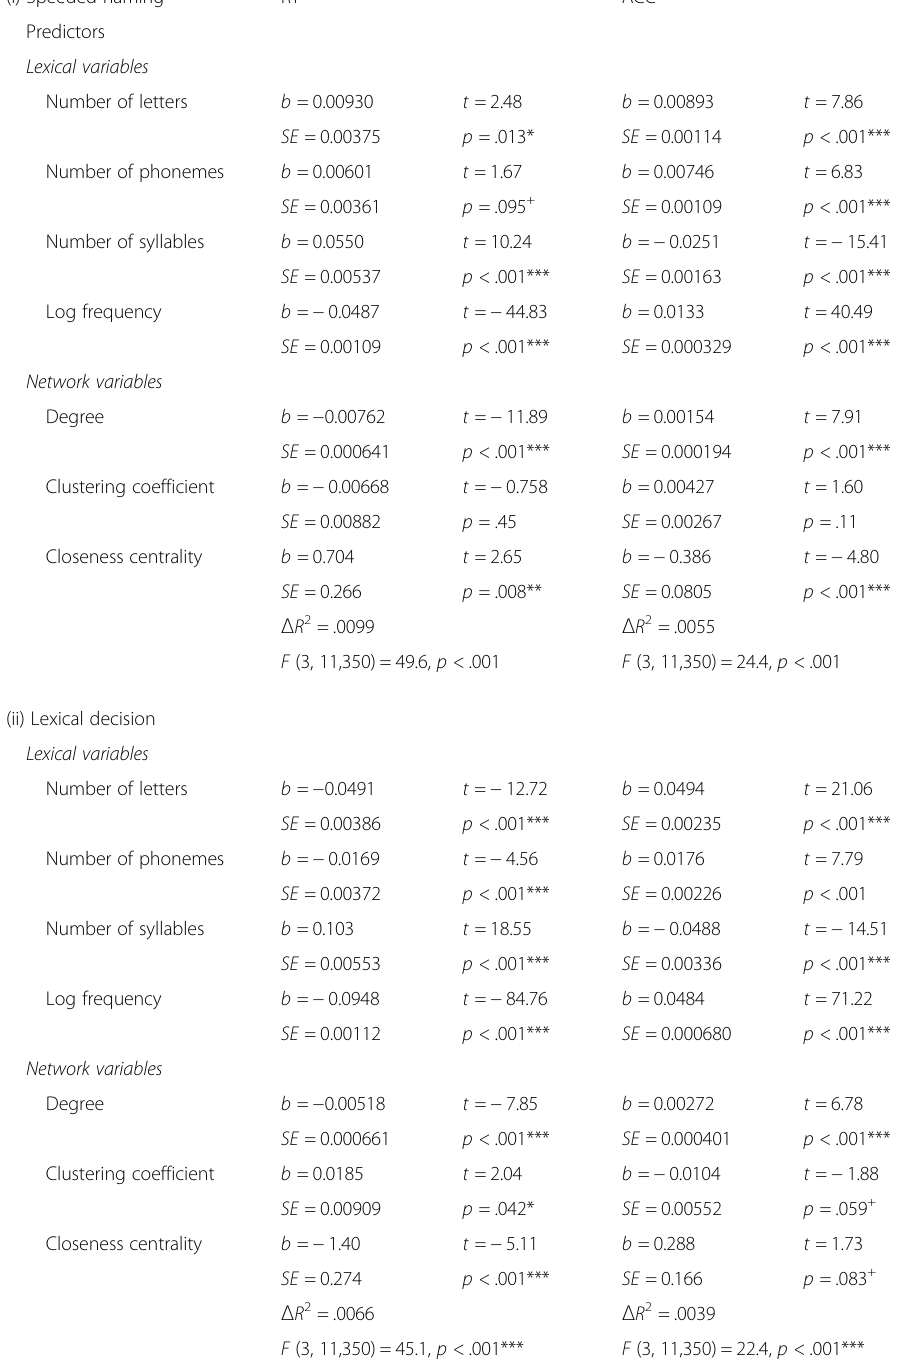
Table 3 Summary of regression results for speeded naming and lexical